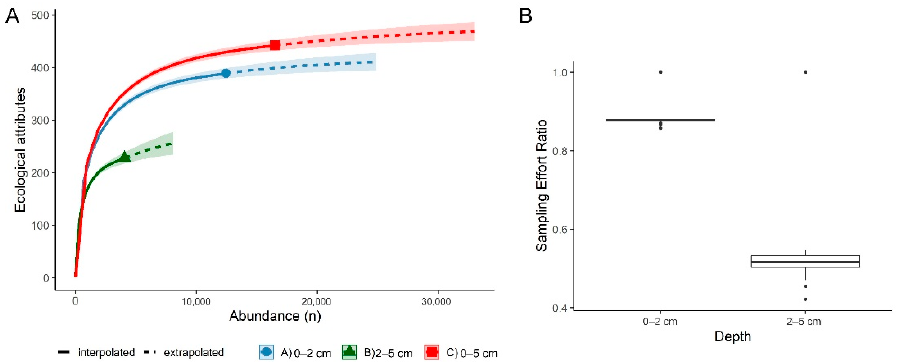
Figure 4. Richness analysis ( A ) Sampling curves for species richness comparing estimates at the different depths (0–2 and 2–5 cm) and comparing them with the total evaluated layer (0–5 cm). The shaded areas represent the confidence intervals. ( B ) Sampling effort ratio at integrated and subsurface layer.